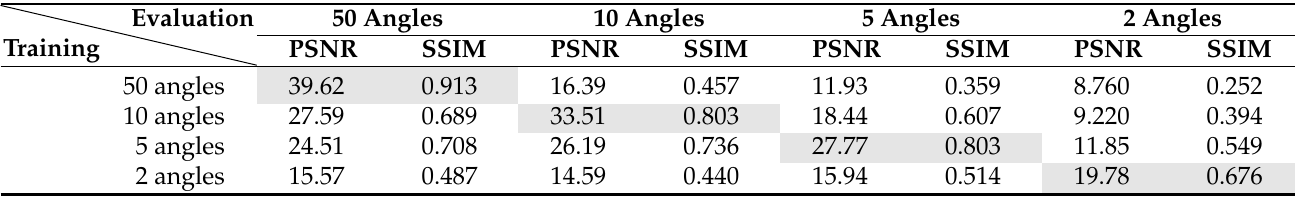
Table 5. Performance of a U-Net trained on the Apple CT dataset (scattering noise) and evaluated on different angular samplings. In general, a U-Net trained on a specific number of angles fails to produce good results on a different number of angles. PSNR and SSIM are calculated with image-dependent data